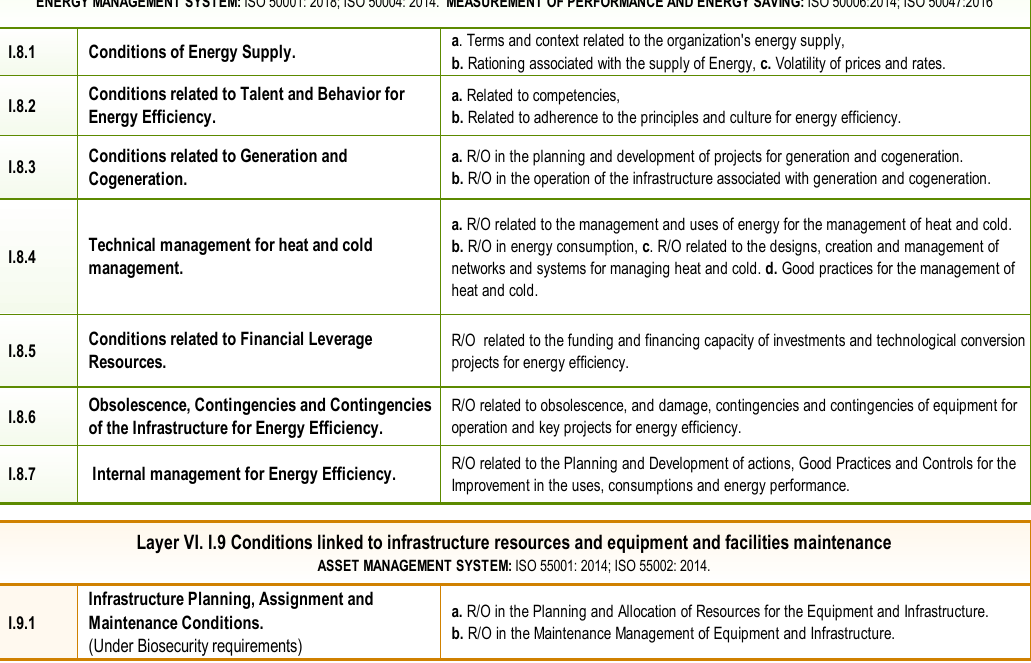
Figure A13. Classification matrix of topics related to internal R/O. Layer V: I.8, and Layer VI: I.9